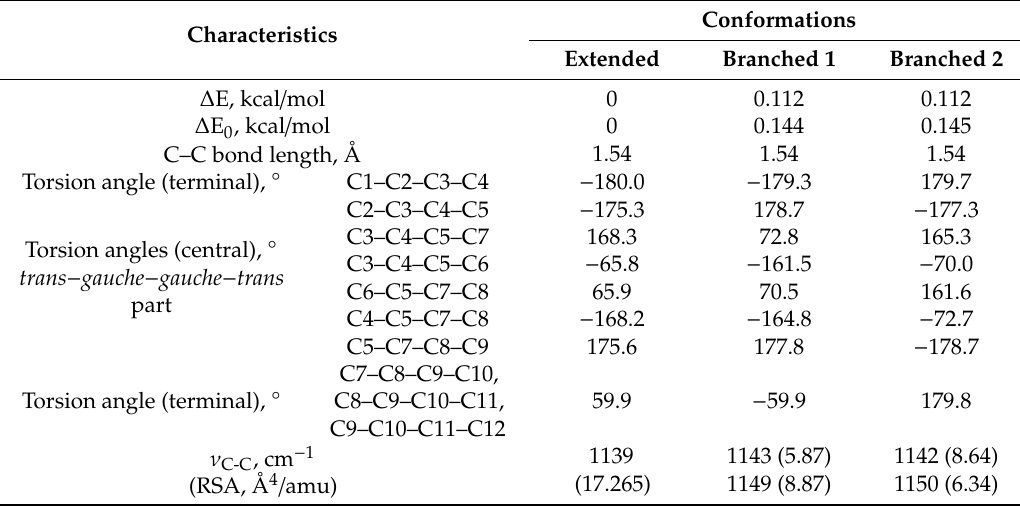
Figure 8. Density functional theory (DFT) calculated conformations of dimers of 1-hexene ( a – c ) and 1-octene ( d – f ): extended-chain conformation ( a , d ), branched 1 chain conformation ( b , e ), branched 2 chain conformation ( c , f ). Table 2. DFT calculated characteristics of the hydrogenated 1-hexene dimer